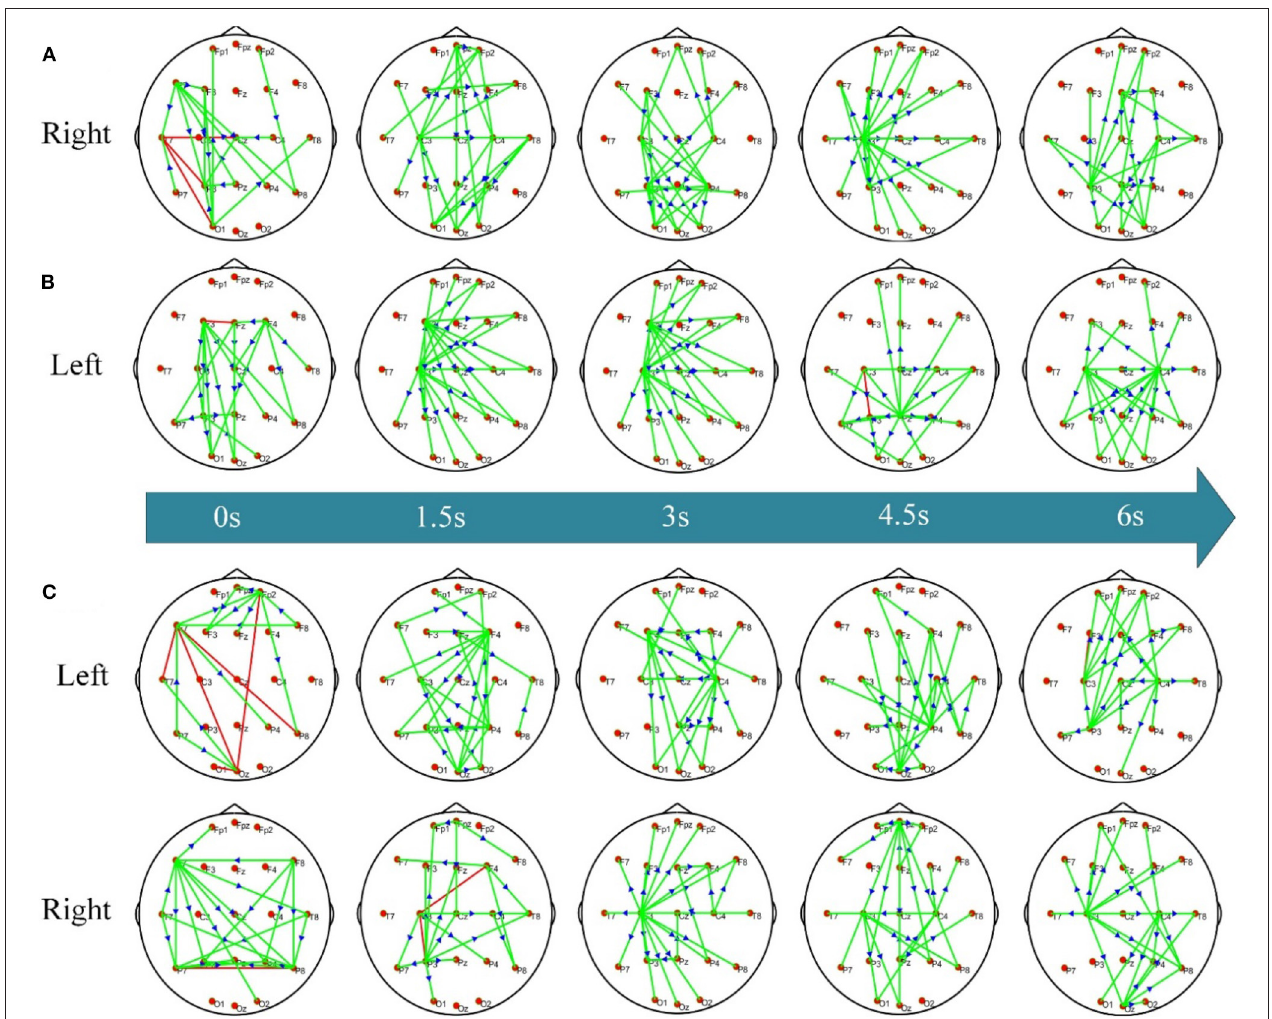
FIGURE 3 | The dynamic KMI network patterns of RS/LS/HC. (A) Time-varying network pattern in the right hand of the RS group; (B) time-varying network pattern of the left hand in LS group; (C) time-varying network pattern of left/right hand in HC group. The connecting edge in the figure represents the coupling relationship between the two electrodes, the red edge represents the two-way connection between the two nodes, the green edge represents the one-way connection between the nodes, and the arrow represents the flow direction between